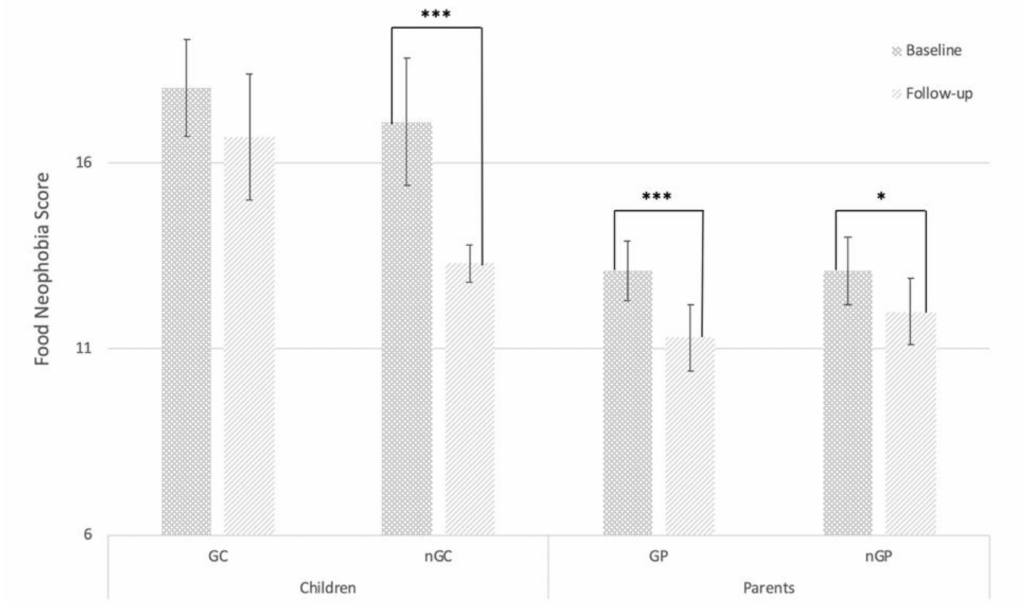
Figure 2. Mean ( ± SEM) range of food neophobia scale (FNS) score at baseline and follow up. Abbreviations: Game-children (GC), non-game-children (nGC), game-parents (GP), non-game-parents (nGP). Significance level estimated by a linear mixed model. Significance levels: *** p < 0.001, ** p < 0.01, * p < 0.05.